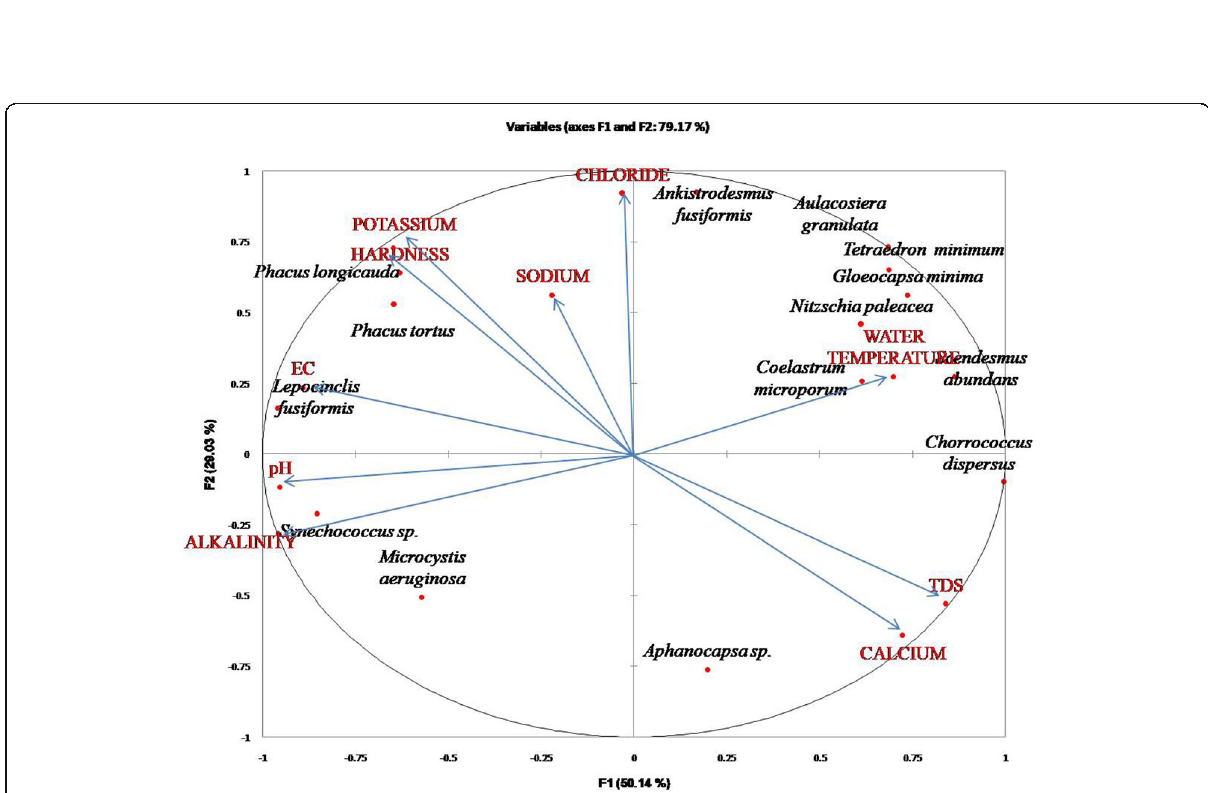
Fig. 6 Principal Component Analysis of physico-chemical parameters and dominant species of Braham